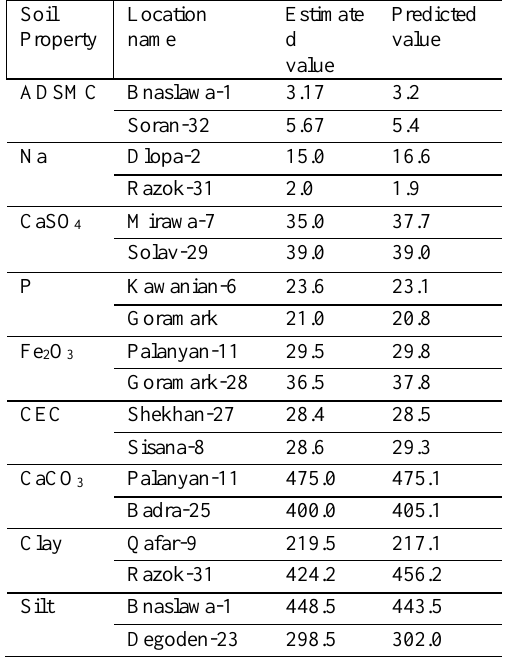
Table 3. The measured and predicted surface soil properties values of some study locations.